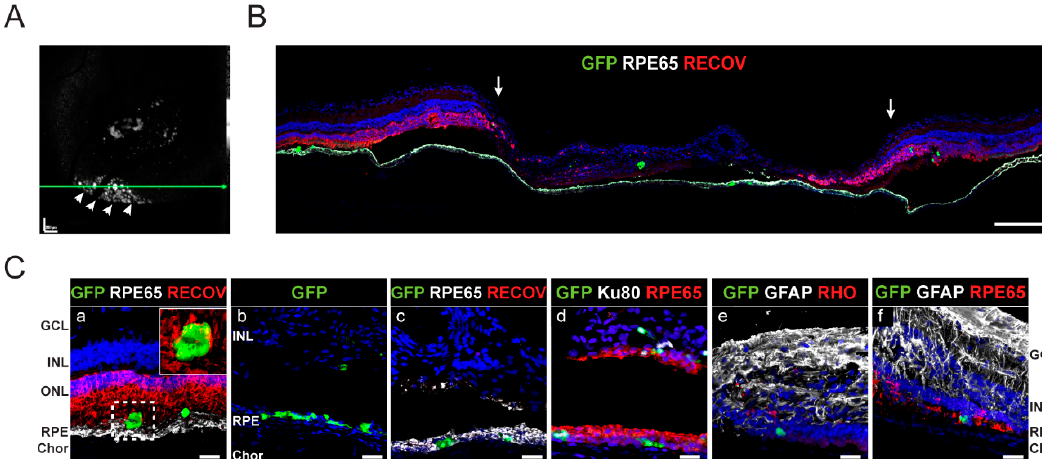
Figure 7. Analysis of hiPSC-RPE cell engraftment in atrophic porcine retinas in pigs 7 and 1. ( A ) In vivo FAF corresponding to the atrophic area transplanted with hiPSC-RPE cells in pig 7 at three months post-transplantation shows punctual integration of cells that are more prominent in the atrophic border (white arrowheads). Scale bar: 600 μ m. (Green horizontal line show OCT scan level, not shown)( B ) Immunostaining composition of the atrophic area stained with RPE65 and recoverin (RECOV) corroborates punctual engraftment of hiPSC-RPE cells. Arrows indicate atrophy borders. Scale bar: 250 μ m. ( C ) Detailed confocal images of hiPSC-RPE cells engrafted in the atrophy margin (a) located in the RPE layer (RPE65) interacting with photoreceptors (RECOV), and in the atrophy (b–e) within the RPE layer (RPE65) and the remaining INL. Transplanted hiPSC-RPE expressed human nuclei marked with Ku80 (d). Astrocyte disorganization is shown by GFAP (e,f) and the lack of photoreceptor by RECOV (c) and rhodopsin (RHO) (e). Scale bars: 25 μ m. At six months, few hiPSC-RPE cells integrated in the RPE layer (RPE65) within the atrophic area (f). Scale bars: 50 μ m. Cell nuclei were stained with DAPI (blue). FAF, fundus autofluorescence; RPE, retinal pigment epithelium; ONL, outer nuclear layer; INL, inner nuclear layer; GCL, ganglion cell layer; Chor, choroid; GFP, green fluorescent protein.